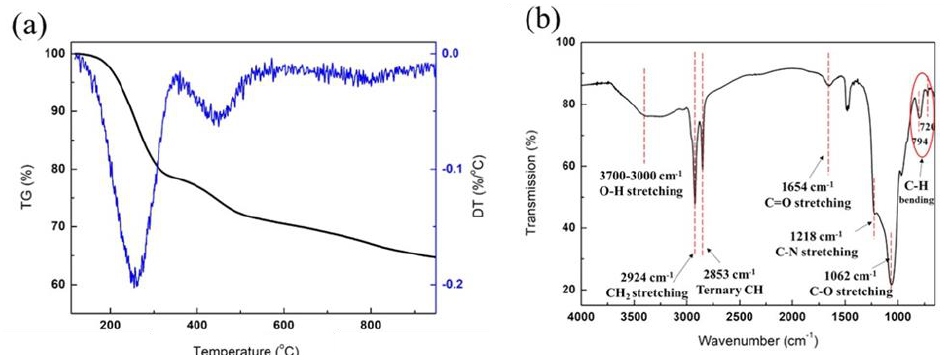
Figure 6. TG/DTA and FT-IR results: ( a ) TG/DTA result and ( b ) FTIR spectra of fresh χ − Fe 5 C 2 @SiO 2 _H